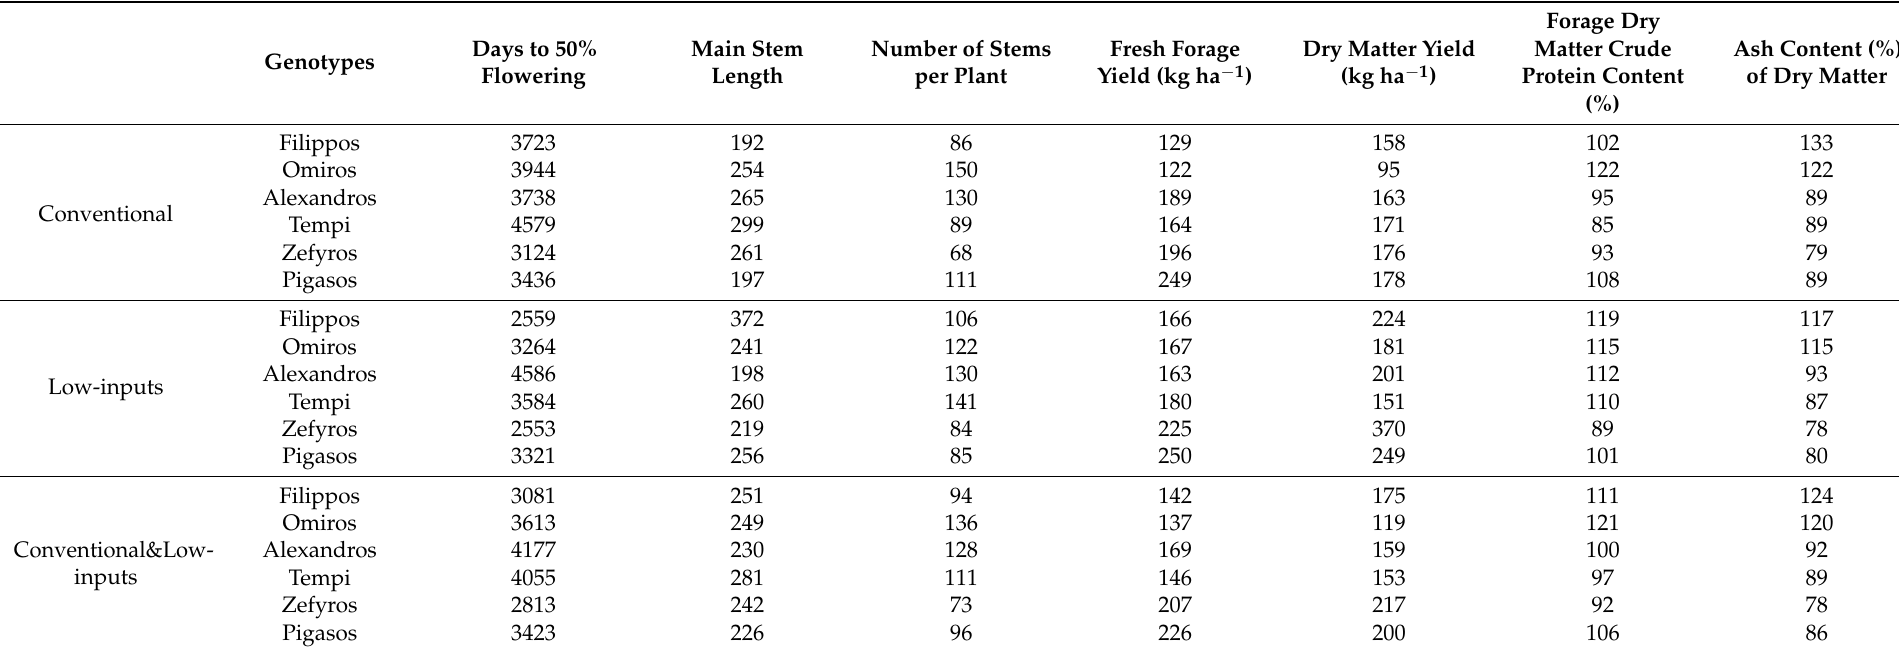
Table 3. Trait stability index across genotypes for the two farming systems: days to 50% flowering, main stem length, number of main stems per plant, fresh forage yield (kg ha − 1 ),